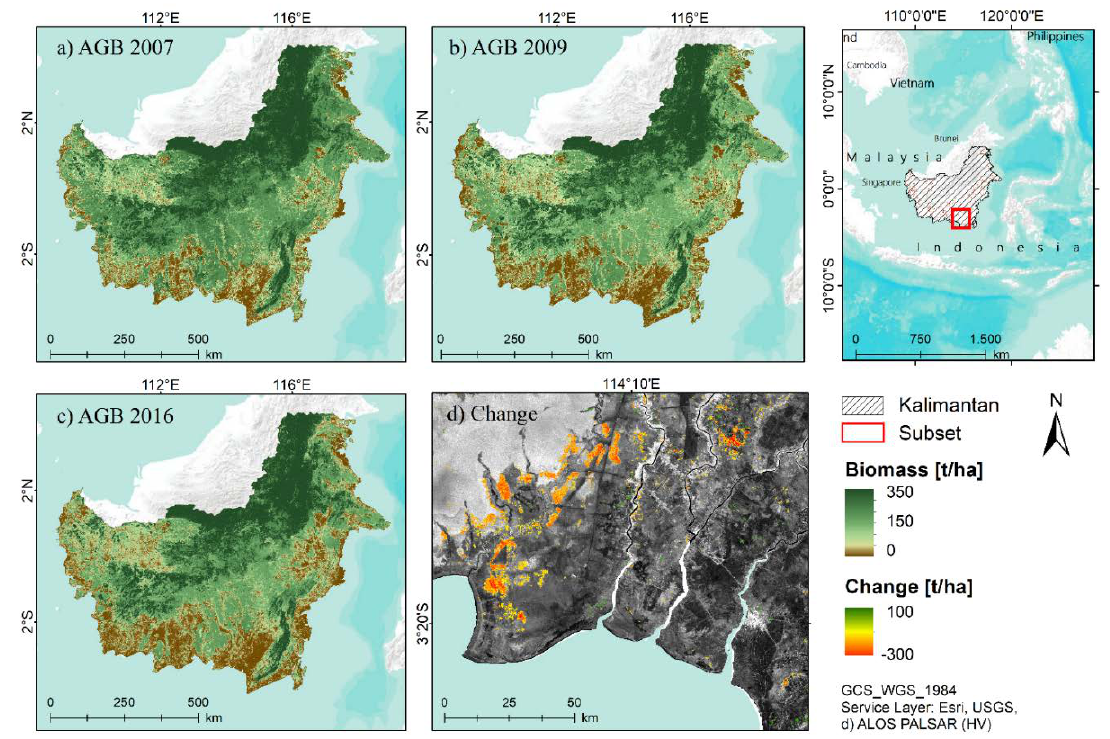
Figure 3. Final biomass maps for Kalimantan, per year and subset of the quantity of change layer for 2009–2016. Biomass ranges from 0–350 t/ha, and the quantity of change ranges from − 300–100 t/ha.